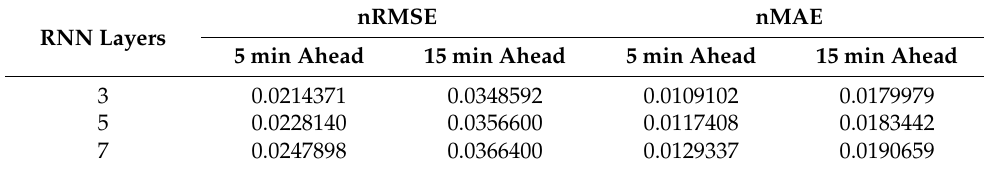
Table 4. Results of very short-term forecasting error by varying the number of RNN layers. RNN Layers